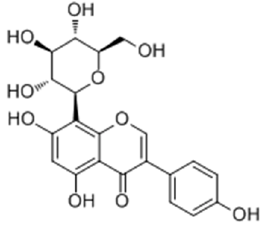
Figure 18. S tructure of puerarin.